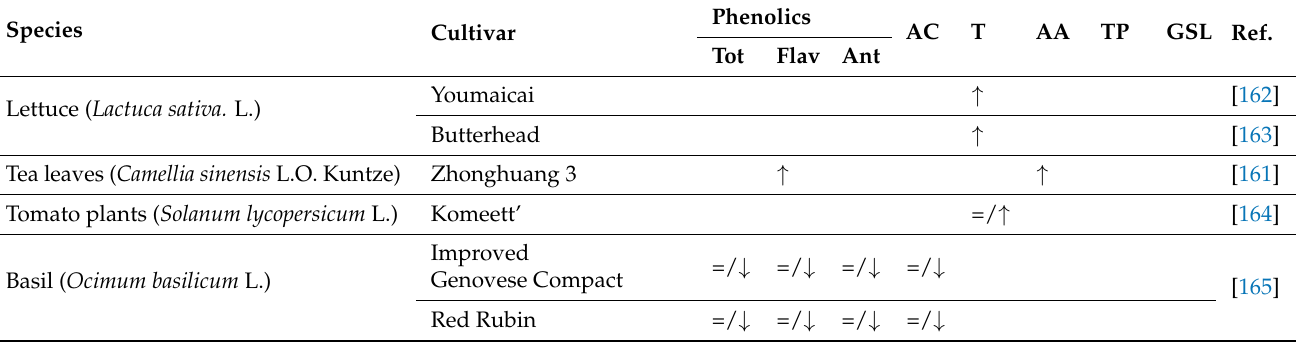
Table 2. Biochemical responses of crops and plants of food interest to green light wavelengths considered in this review. Tot, total phenolics; Flav, flavonoids; Ant, anthocyanins; AC, antioxidant capacity; T, terpenoids; AA, ascorbic acid; TP, tocopherols; GSL, glucosinolates. For each plant species and cultivar, and for each secondary metabolite or metabolic class considered, the symbols “ ↓ ”, “ ↑ ” and “=” mean a decrease, increase or no variations, respectively, compared to the control plants of each study.